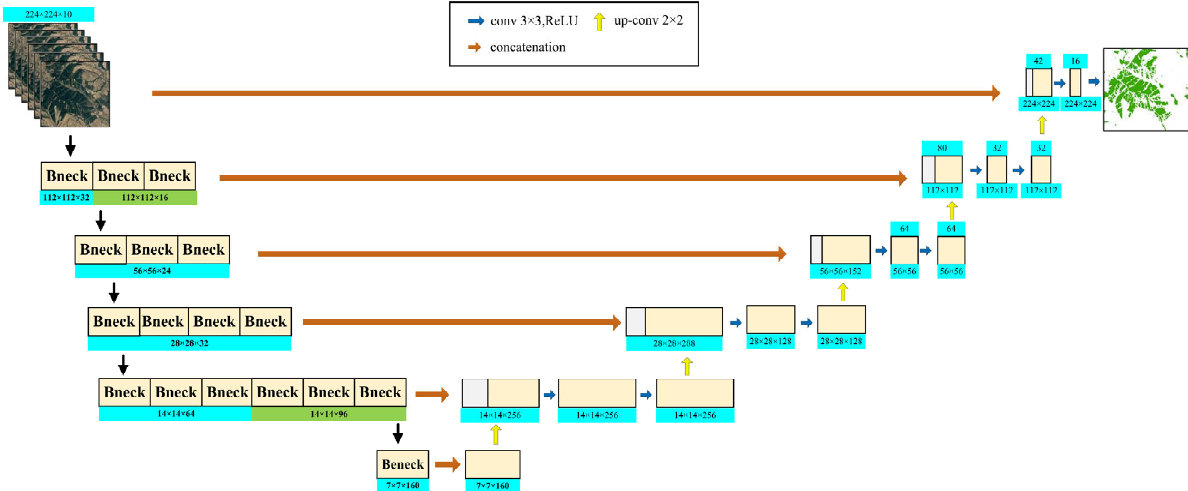
Figure 11. Adapted implementation of the Mobile ‐ UNet architecture.